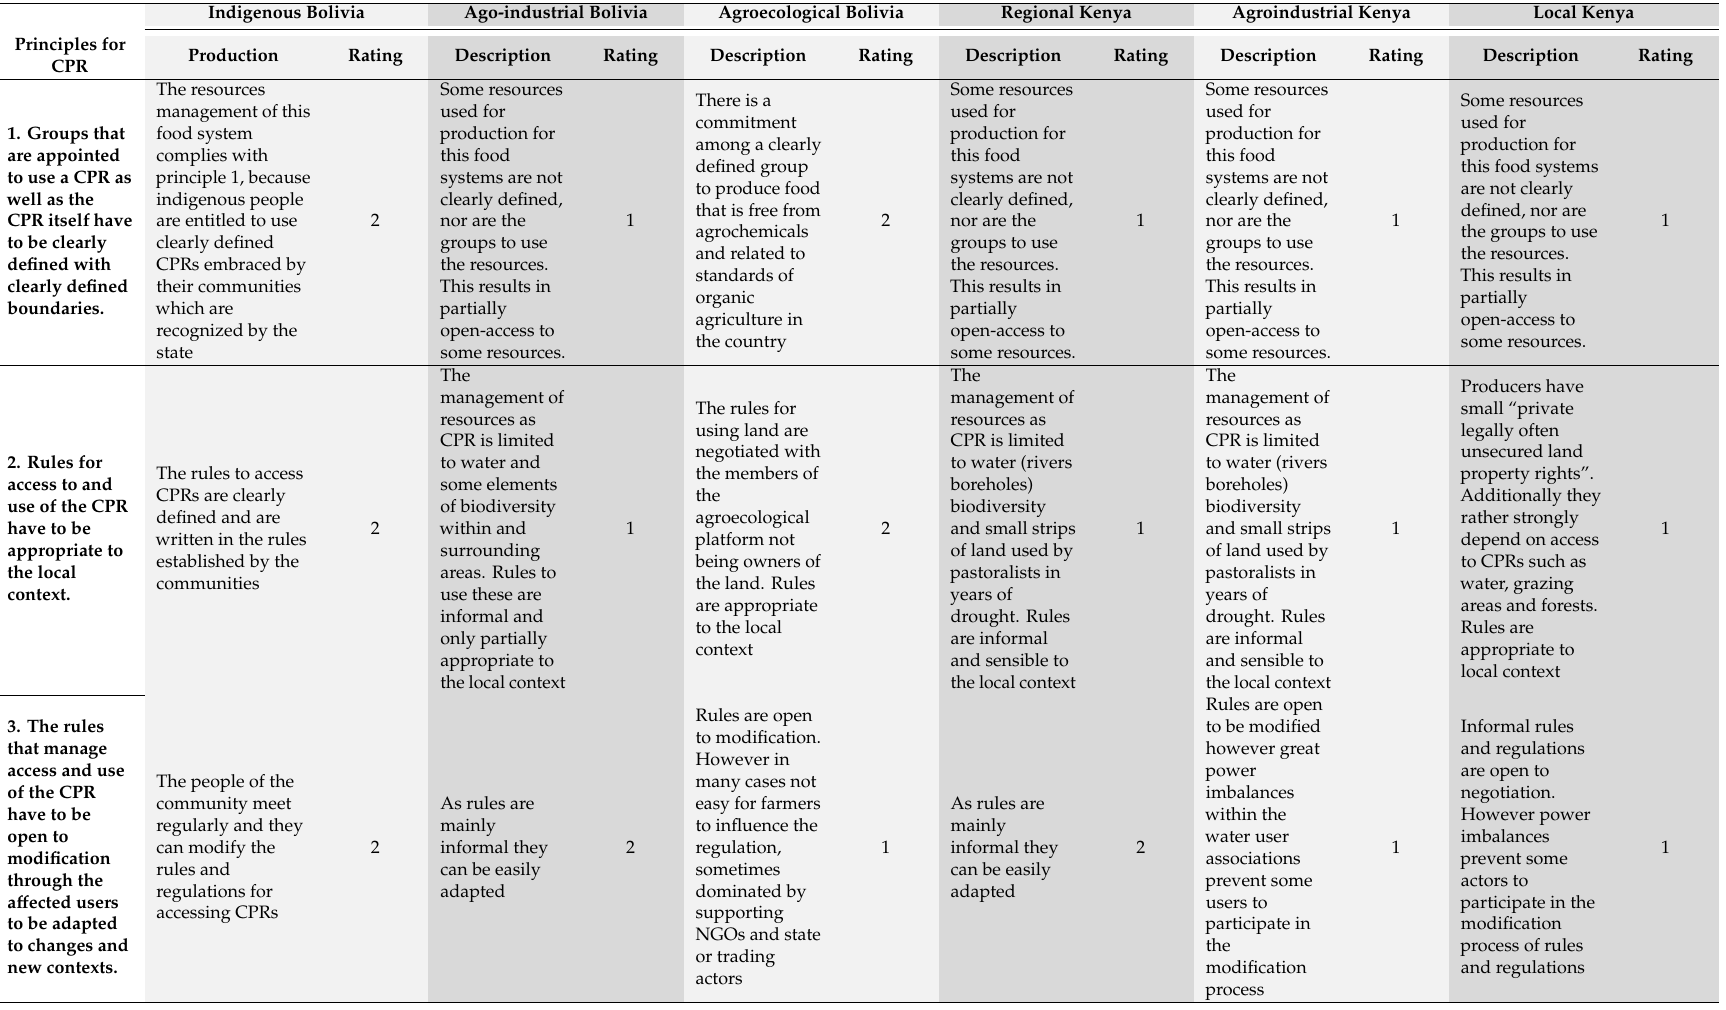
Table 4. CPR compliance assessment of six food